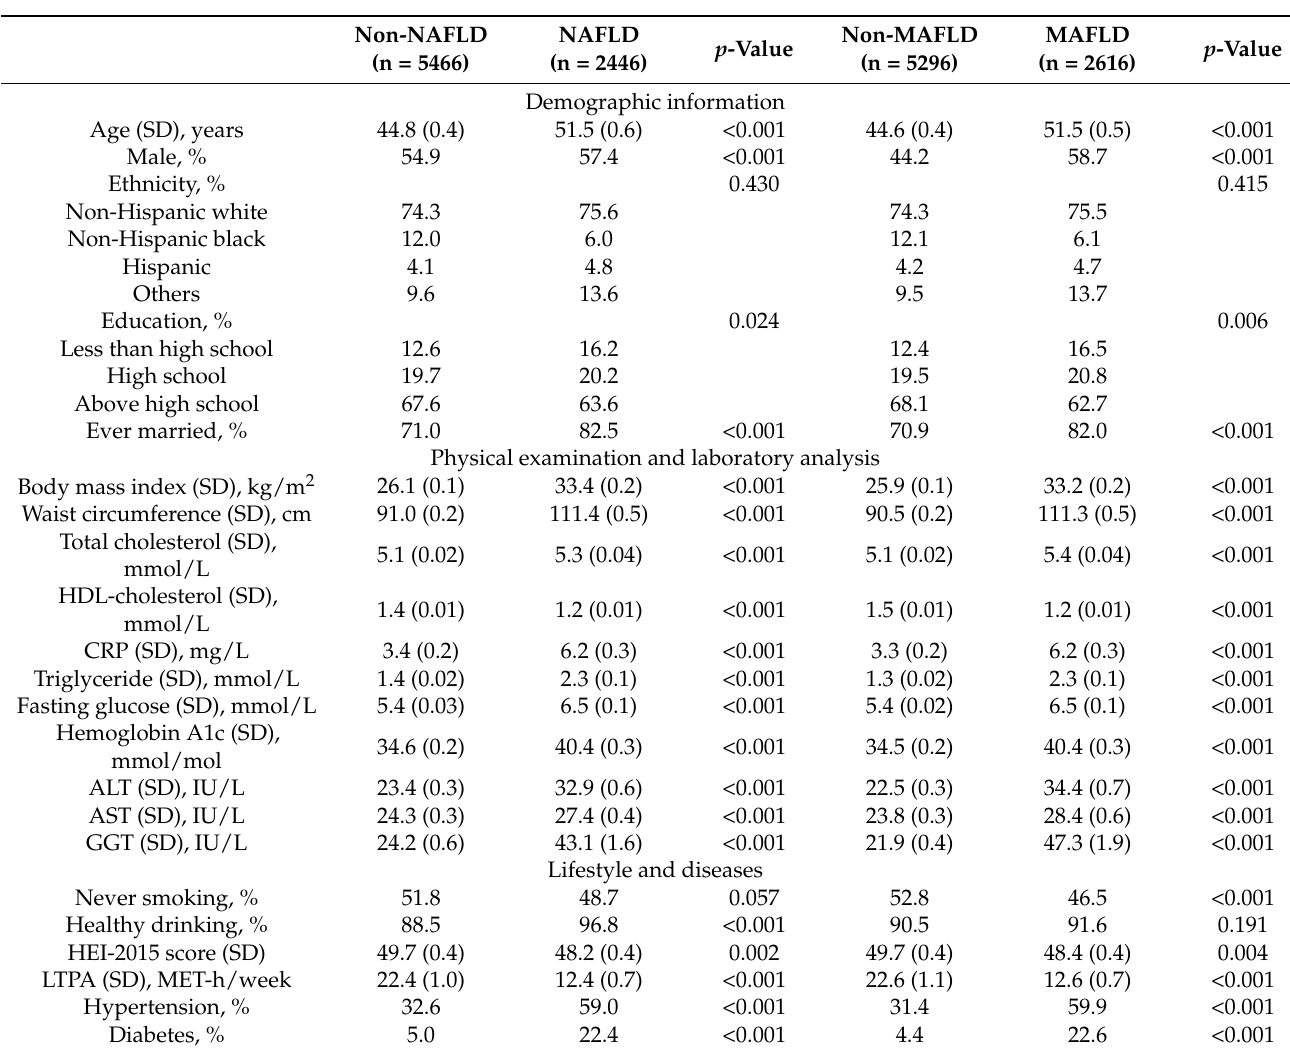
Table 1. Baseline characteristics by MAFLD and NAFLD